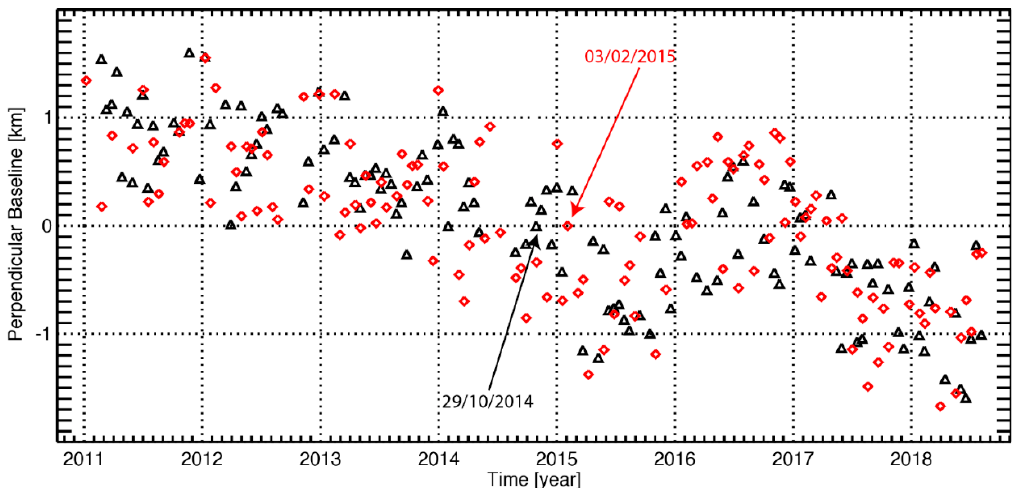
Figure 2. SAR data representation in the temporal / perpendicular baseline plane for the two CSK datasets relevant to the area of interest. The black triangles and the red diamonds represent the ascending and descending acquisitions, respectively. The reference (master) images selected for the processing of the ascending and descending CSK datasets, relevant to the 29 October 2014 and to the 3 February 2015 acquisitions, respectively, are identified by the arrows.